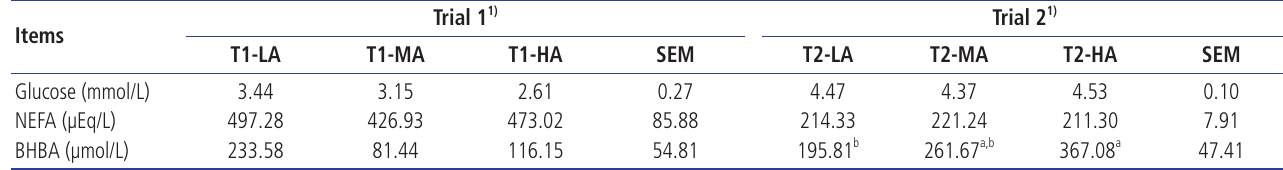
Table 5. Post-trial blood metabolites in Simmental beef calves with different levels of alfalfa hay in their diets Items